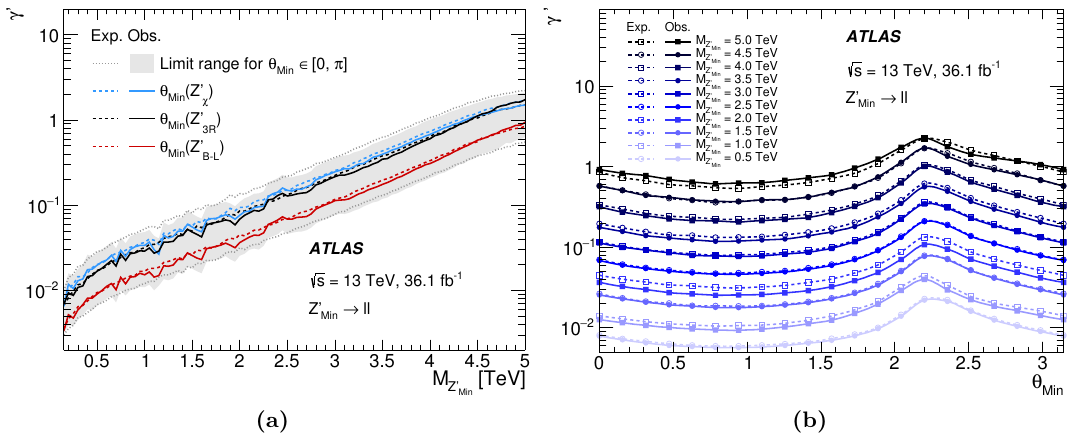
Figure 5 . (a) Expected (dotted and dashed lines) and observed ((cid:12)lled area and lines) limits are set at 95% CL on the relative coupling strength (cid:13) 0 for the dilepton channel as a function of the Z 0 mass in the Minimal Z 0 model. Limit curves are shown for three representative values of Min the mixing angle, (cid:18) Min , between the generators of the (B (cid:0) L) and the weak hypercharge Y gauge groups. These are: tan (cid:18) Min = 0, tan (cid:18) Min = (cid:0) 2 and tan (cid:18) Min = (cid:0) 0 : 8, which correspond respectively to the Z 0 , Z 0 and Z 0 models at speci(cid:12)c values of (cid:13) 0 . The region above each line is excluded. (cid:31) B (cid:0) L 3 R The grey band envelops all observed limit curves, which depend on the choice of (cid:18) Min 2 [0 ; (cid:25) ]. The corresponding expected limit curves are within the area delimited by the two dotted lines. (b) Expected (empty markers and dashed lines) and observed ((cid:12)lled markers and lines) limits at 95% CL on (cid:13) 0 for the dilepton channel as a function of (cid:18) Min . The limits are set for several representative values of the mass of the Z 0 boson, M . The region above each line is excluded. Z 0 Min